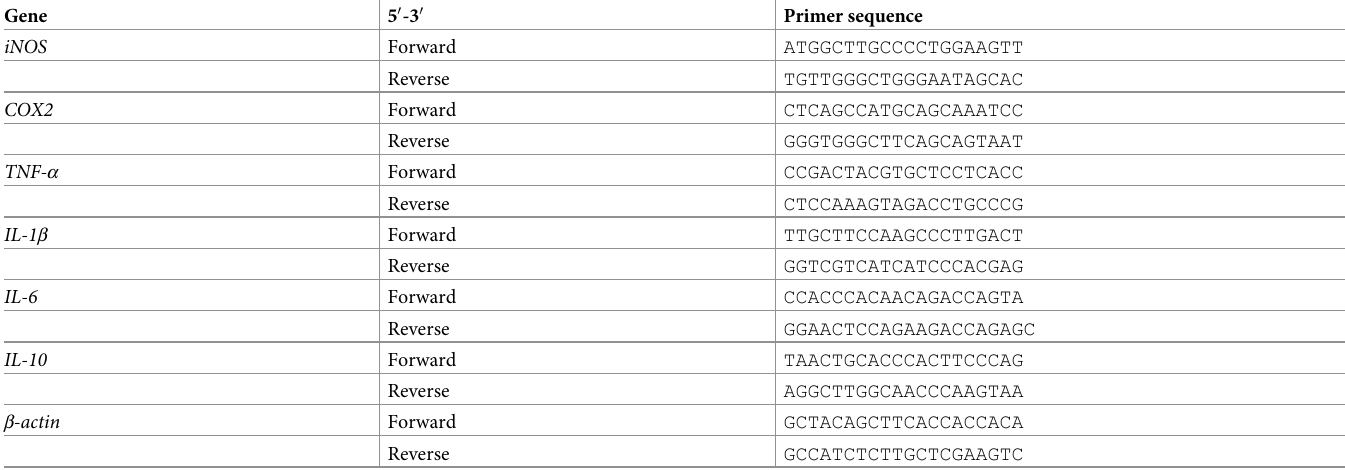
Table 1. Primer sequences used for real-time PCR analysis.